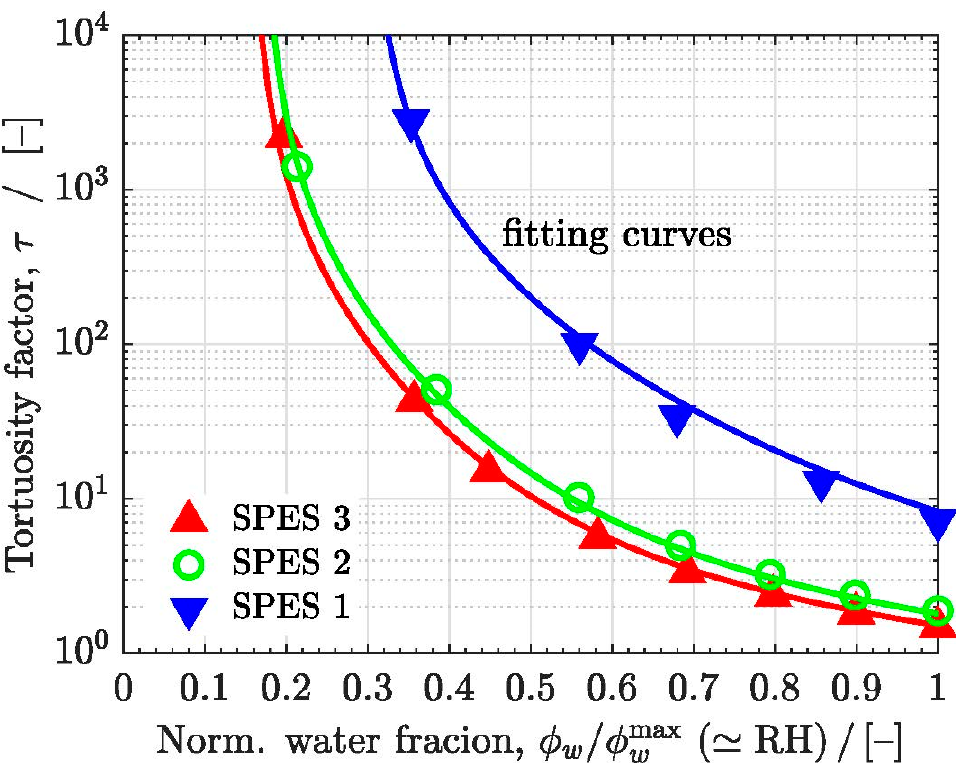
Figure 8. Tortuosity factor τ as a function of the ratio φ w / φ max wr ( (cid:39) RH ) of the SPES membranes. The fitting curves to the data are included.